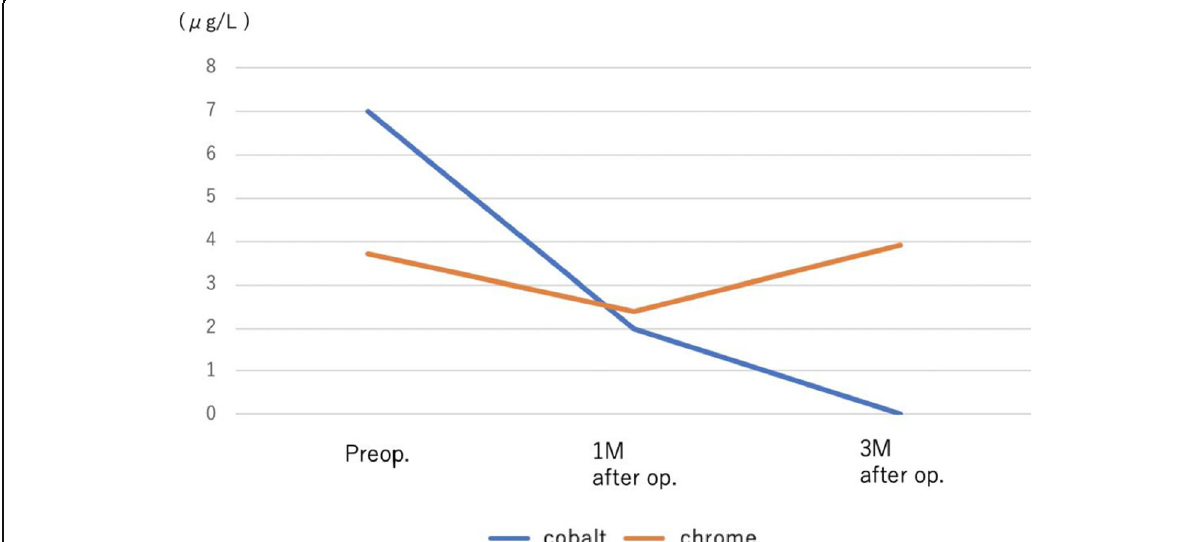
Fig. 7 Changes in postoperative blood metal (cobalt and chromium) concentrations. M, month(s); Preop., preoperatively; op.,